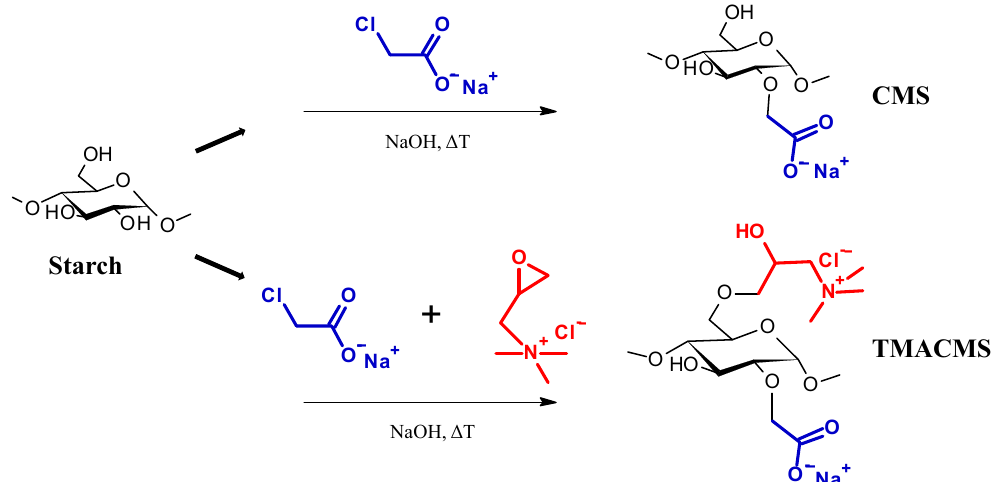
Figure 1. Schematic presentation of the synthesis of the CarboxyMethylStarch (CMS) and TriMethylAmineCarboxy. MethylStarch (TMACMS)